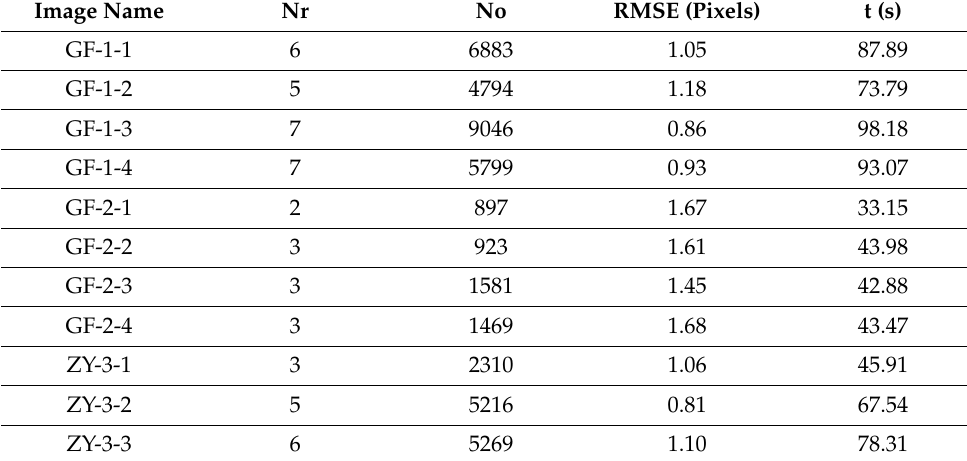
Table 5. The quantitative experimental results of all experimental